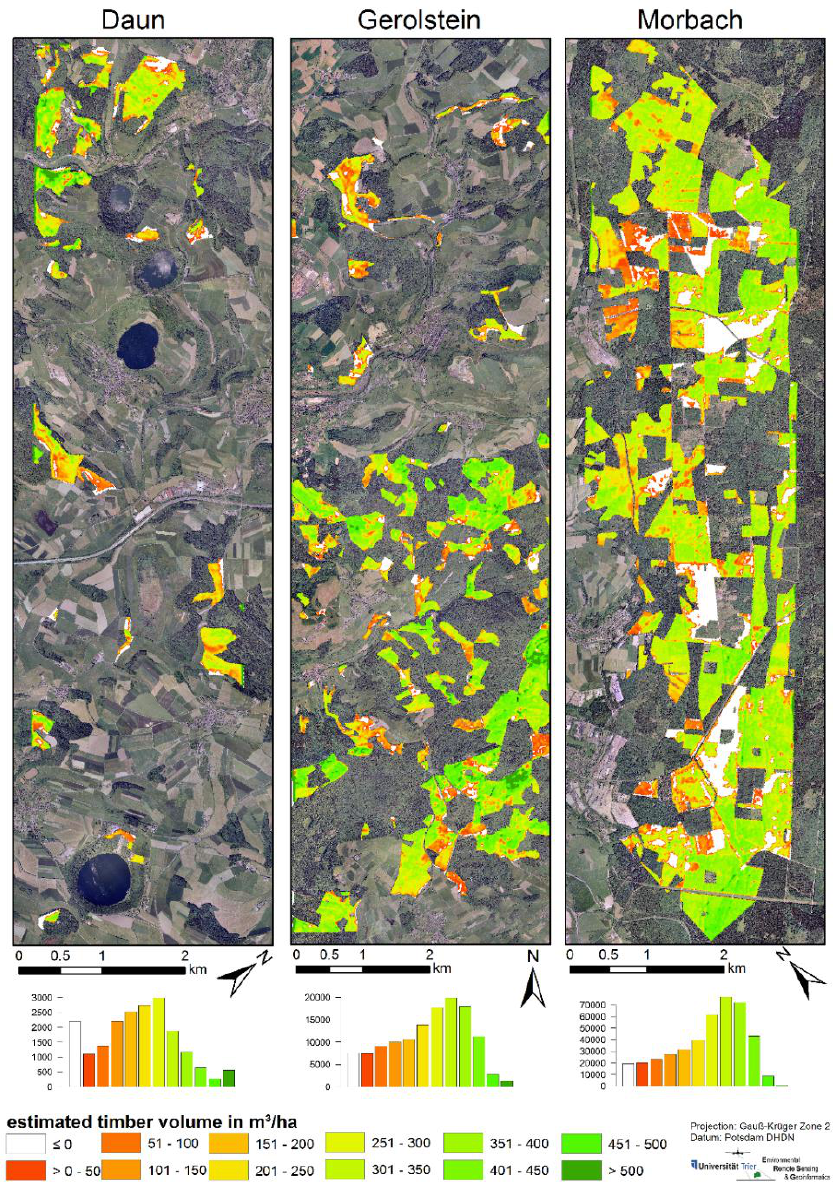
Figure 10. Timber volume prediction map based on PLSR with simulated Sentinel-2